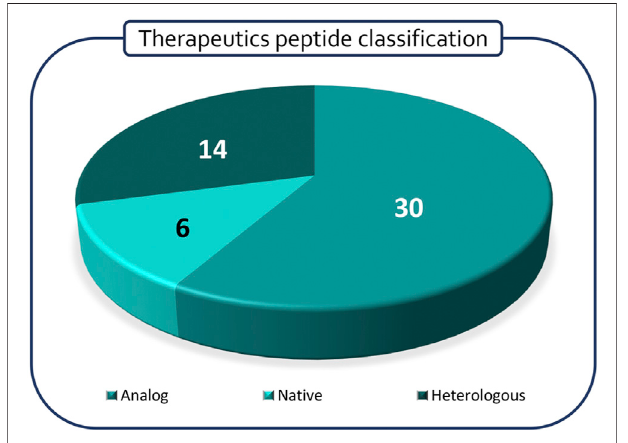
FIGURE 2 | Classi fi cation of discussed peptides according to Lau/Dunn classi fi cation.